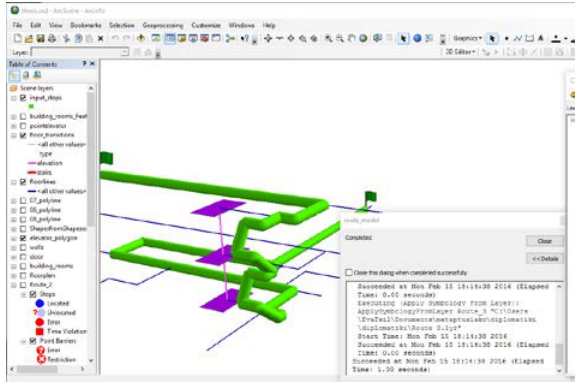
Figure 10. Route succeeded For better comprehension of the output route, the 3D building model from CityEngine can be used for visualising the exterior shell of the construction. The 3D CityEngine model is